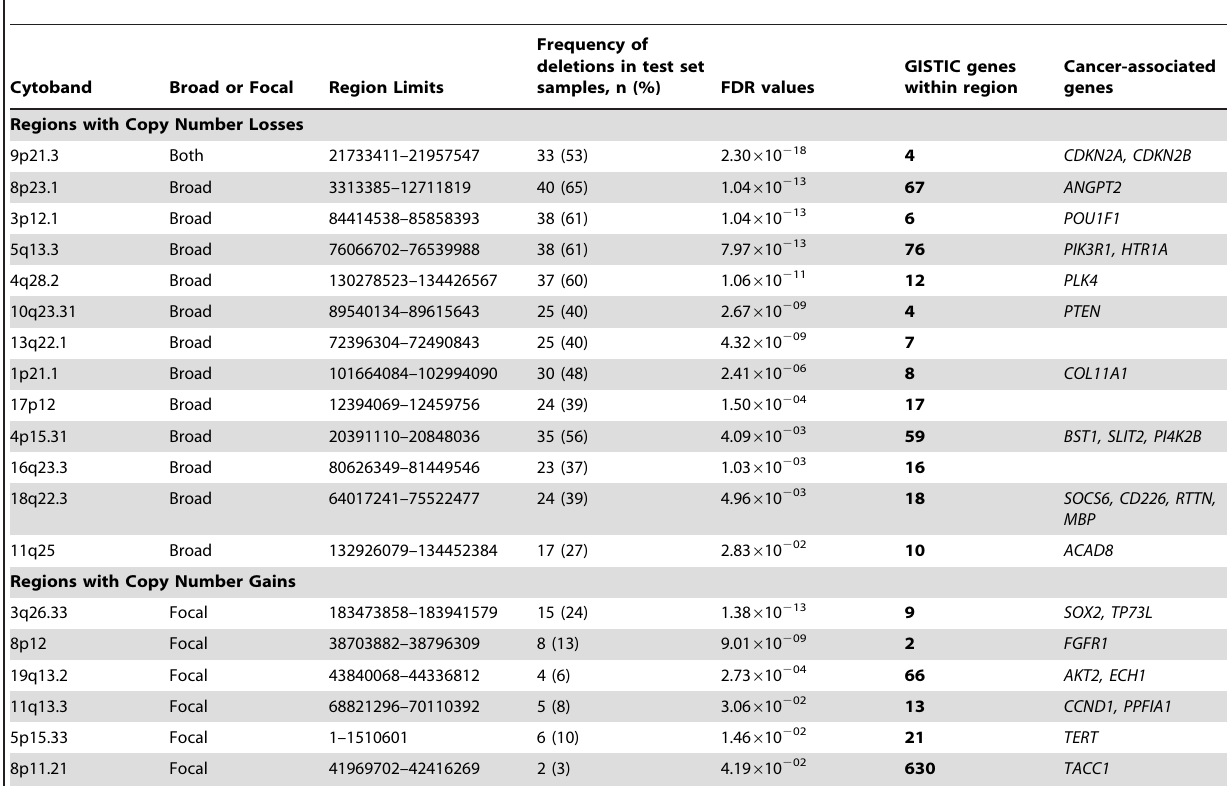
Table 2. GISTIC Identified Chromosomal Regions with Copy Number Alterations in Training Set SCC Tumors.